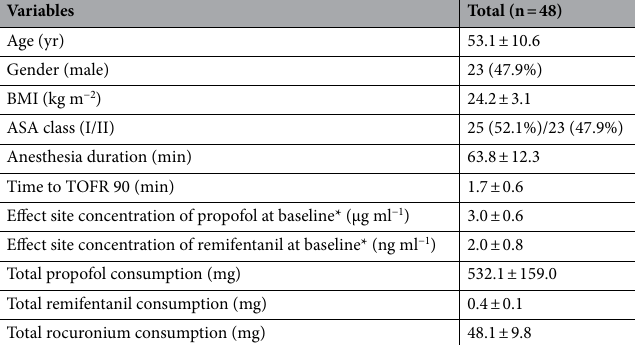
Table 1. Patient characteristics. Data expressed as mean ± SD or n (%). BMI body mass index, ASA American society of anesthesiologists, TOFR train of four ratio. *Baseline was defined as the time point at which sugammadex was